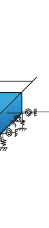
Figure 1: A Mindlin plate with arbitrary elastic point edge